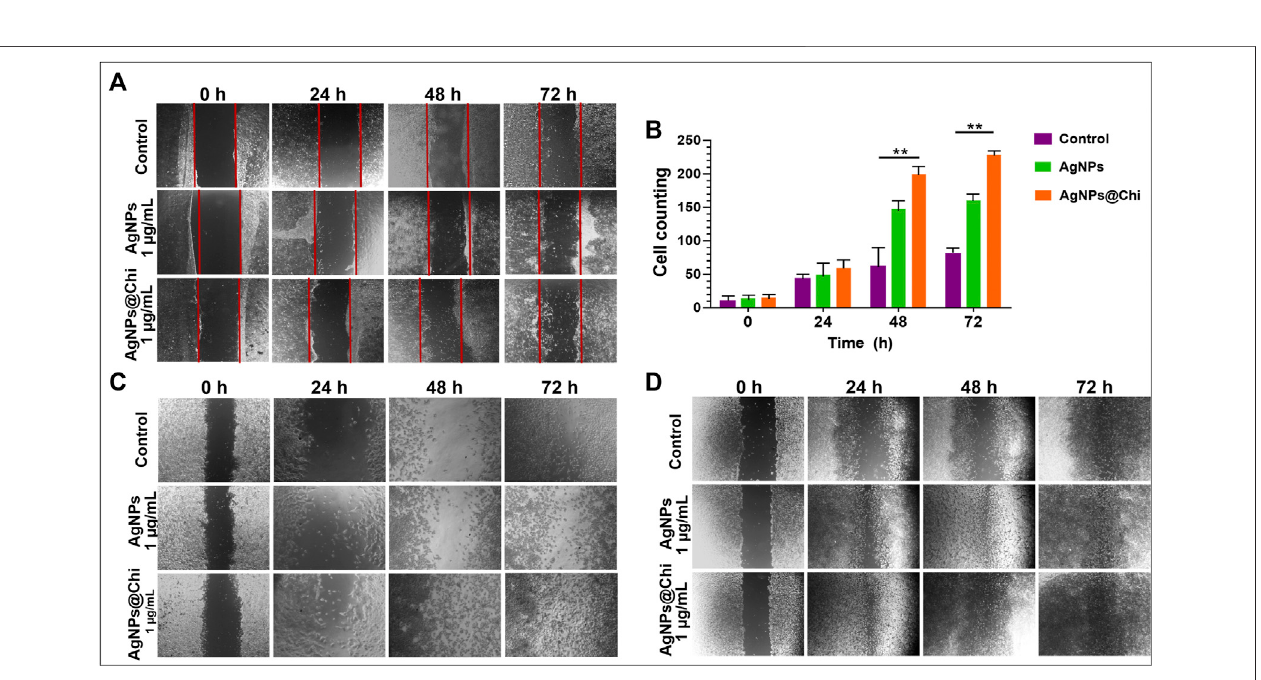
FIGURE3| Invitro migrationofmammaliancells.Cells(10 6 )wereplatedin6-wellplatesandstimulatedforupto72 htonanocompositespreviouslydilutedinRPMI 1640/0.2% FBS. The cell monolayer was scratched with a tip and monitored until cell convergence. Images representative both (A) Human keratinocytes and (C) fi broblast,and (D) NIH/3T3 fi broblastcellswereacquiredusinga4×objectivelens[exceptforthosecorrespondingto24 hin (C) (10×)]. (B) representsthekeratinocytes counting [cells within the area bounded by the red lines in (A) ] of an experiment performed in duplicate. Experimental data was analyzed using Dunnett ’ s multiple comparison test, ** p ˂